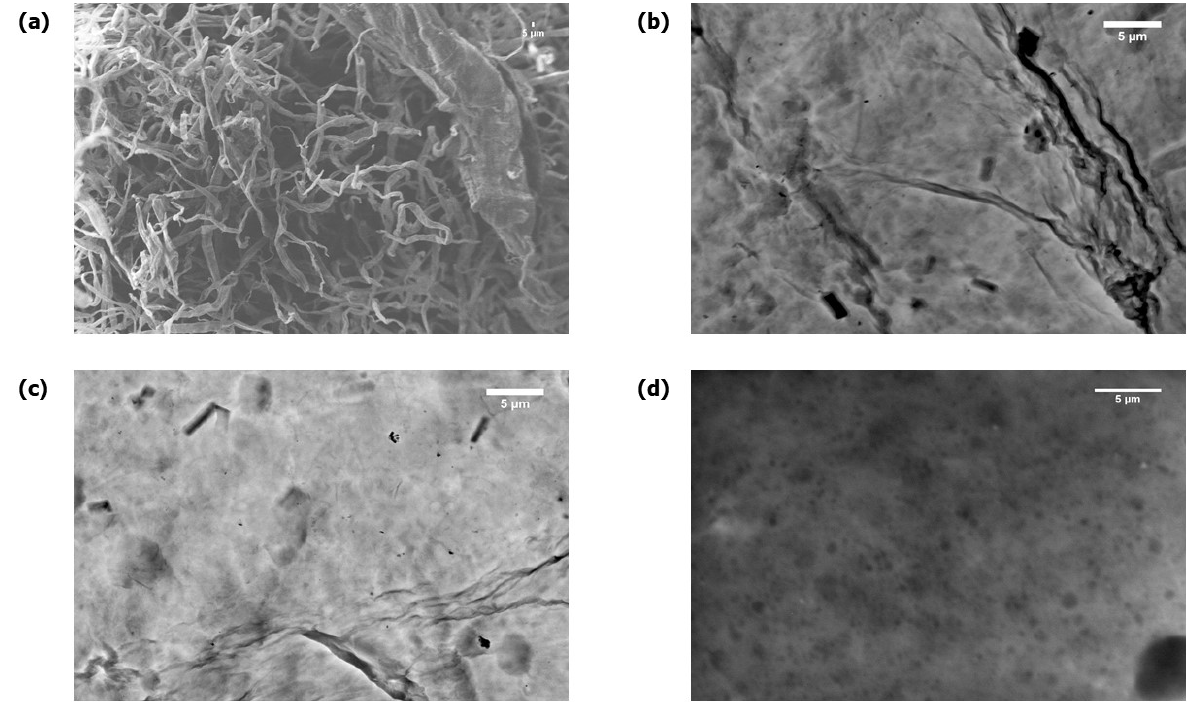
Figure 3: The SEM images of (a) α-cellulose, (b) CNF1, (c) CNF2 and (d)